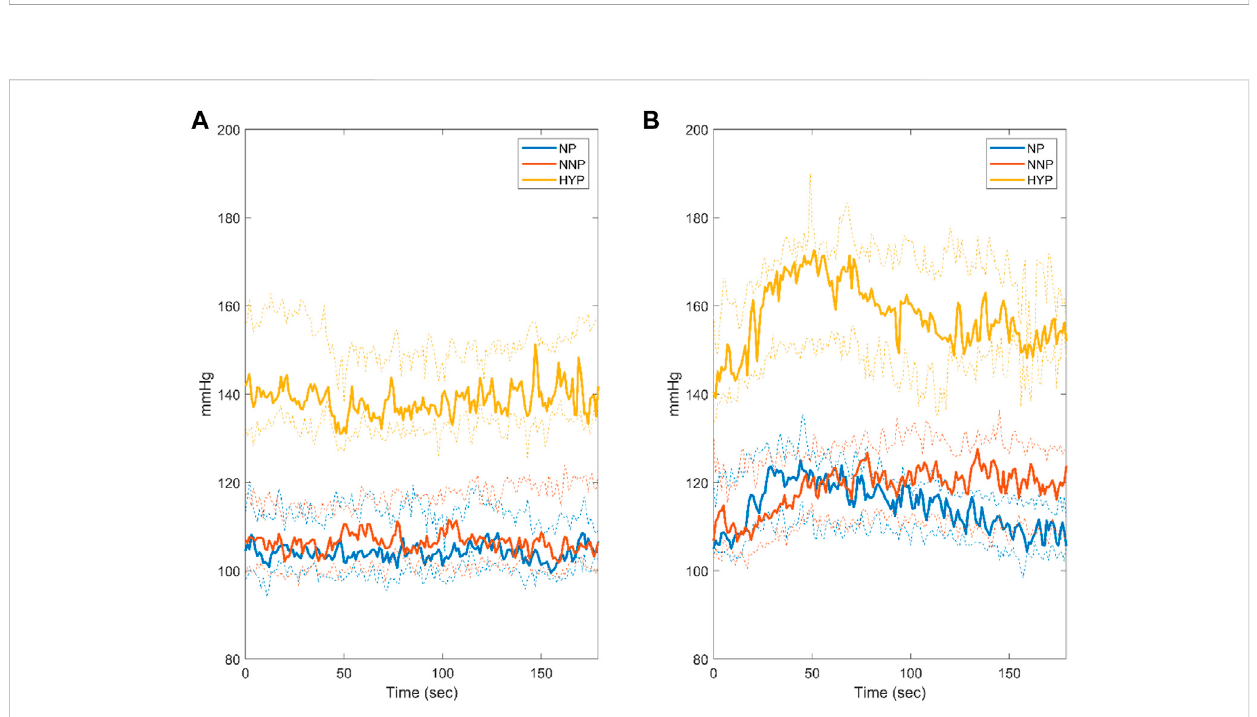
FIGURE 3 Systolicbloodpressureresponseduringrest (A) andcoldpressortest (B) fornormotensivepregnantwomen(NP,blue),normotensivenon-pregnant women (NNP, red), and hypertensive pregnant women (HYP, yellow). The solid line shows the median with its 95%